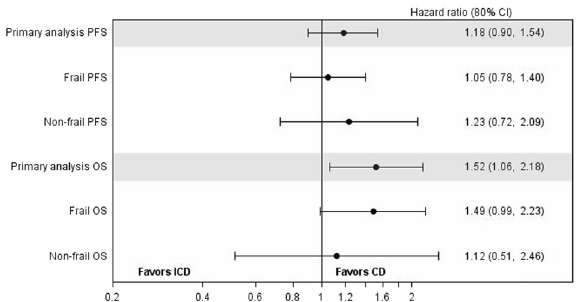
Fig. 4 Forest plots of progression-free and overall survival by frailty